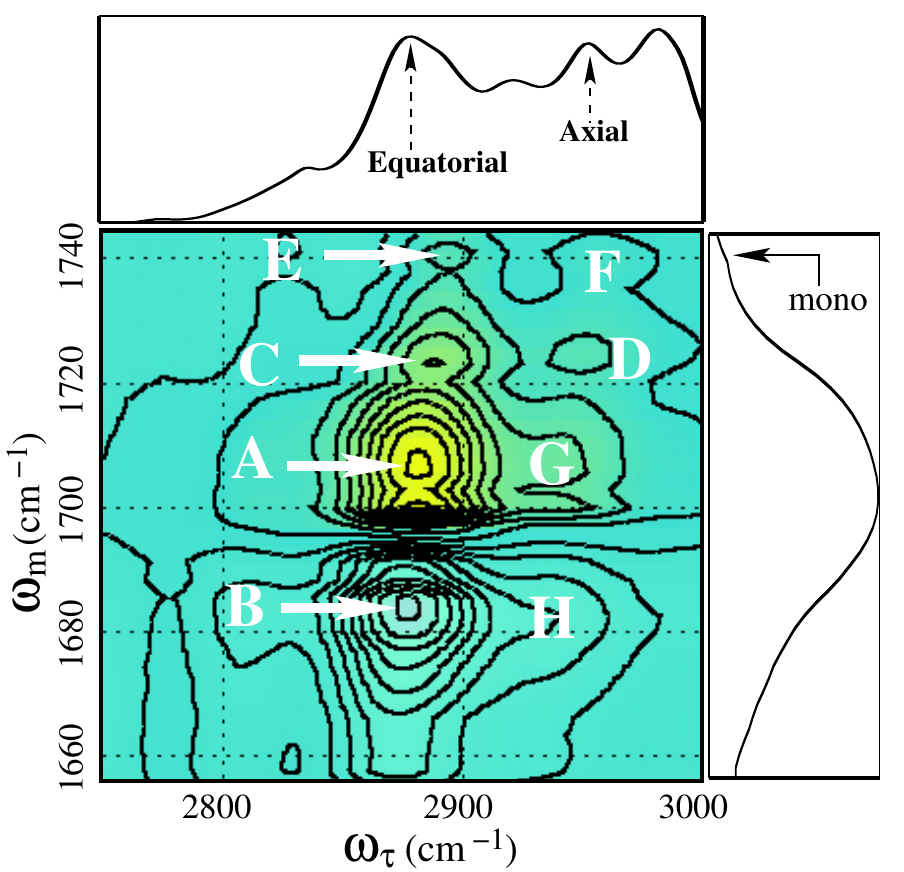
Figure 10. Two-dimensional vibrational photons echo real spectra at the CHCO coupling region of 2-Pyrrolidinone at a population tine T w = 3000fs. Spectra is taken by pumping at the C-H vibrational modes and probing at the C=O vibrational mode. The 1DIR spectra at the C-H vibrations region is embedded on top, and the C=O spectral region on the right side of 2DIR spectra for a better understanding of the peak position. Two-dimensional data have been normalized to the highest peak